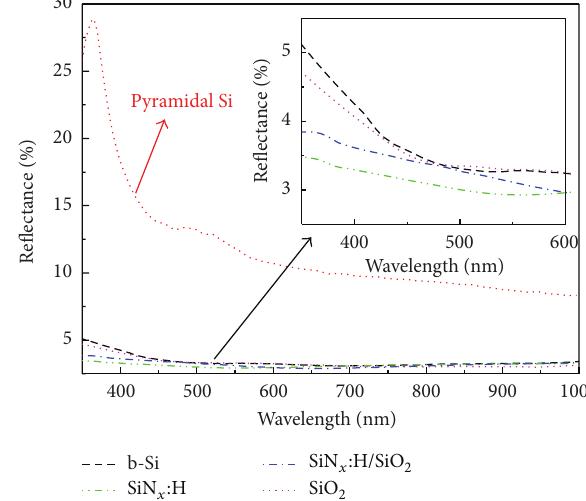
Figure 3: Reflectance as function of wavelength of b-Si and pyramidal Si. Insert shows the reflectance of b-Si and b-Si with different passivation films including SiO 2 , SiN respectively. b-Si, b-Si with SiO 2 , SiN 3.29%, 3.08%, and 3.20%, respectively. A remarkable